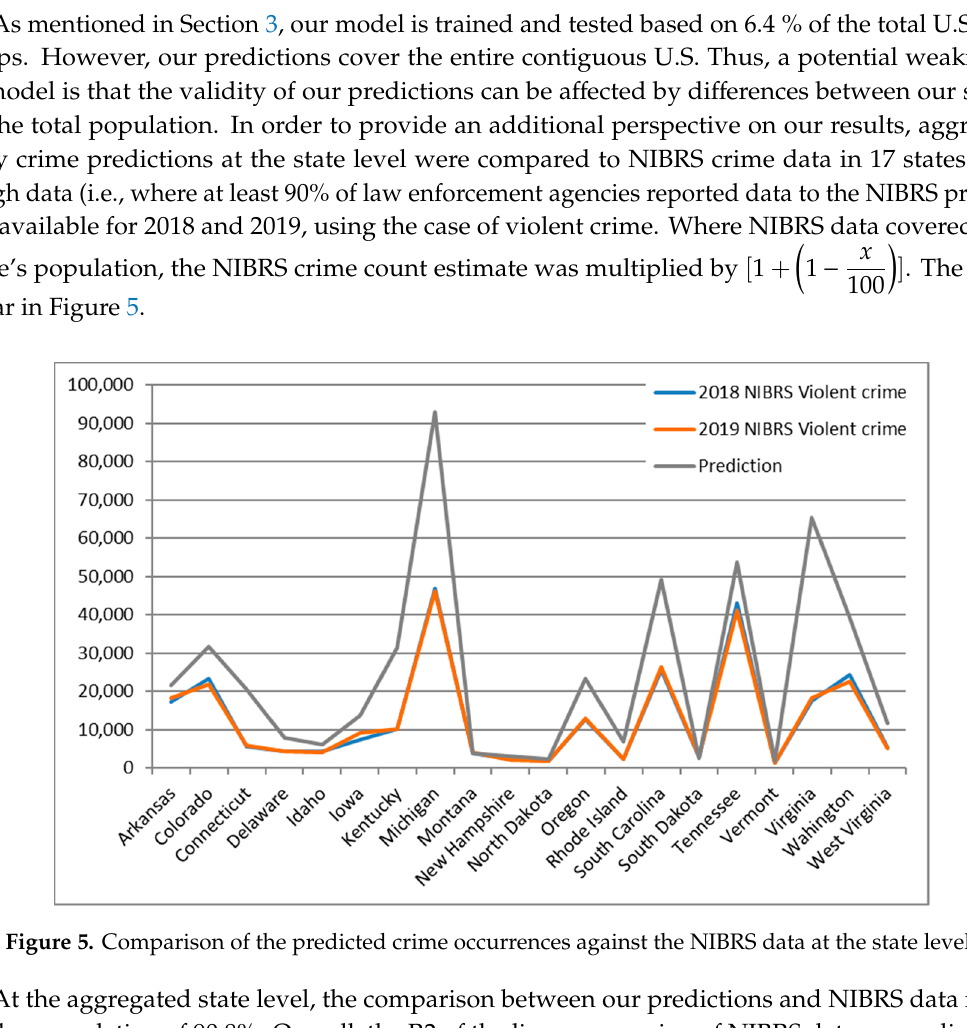
Figure 5. Comparison of the predicted crime occurrences against the NIBRS data at the state level.